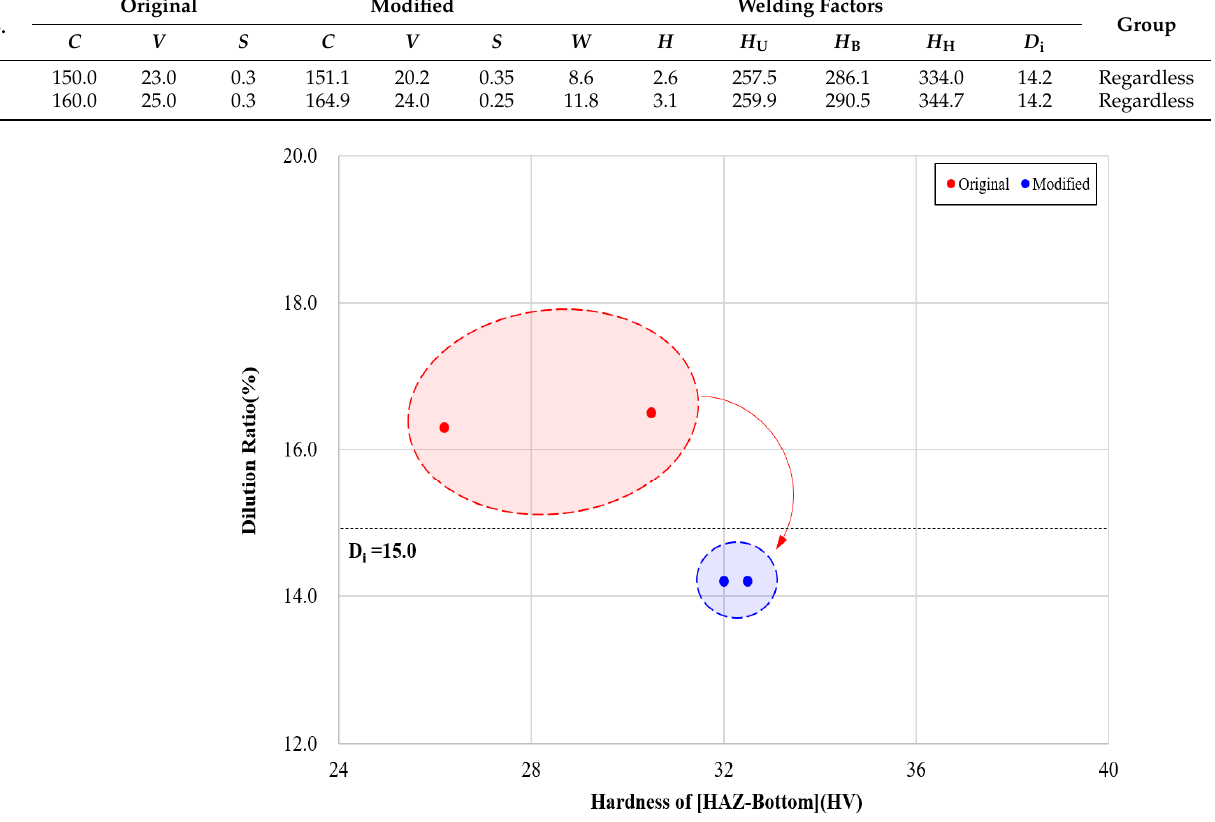
Table 13. Results of welding parameters modified by optimization process.